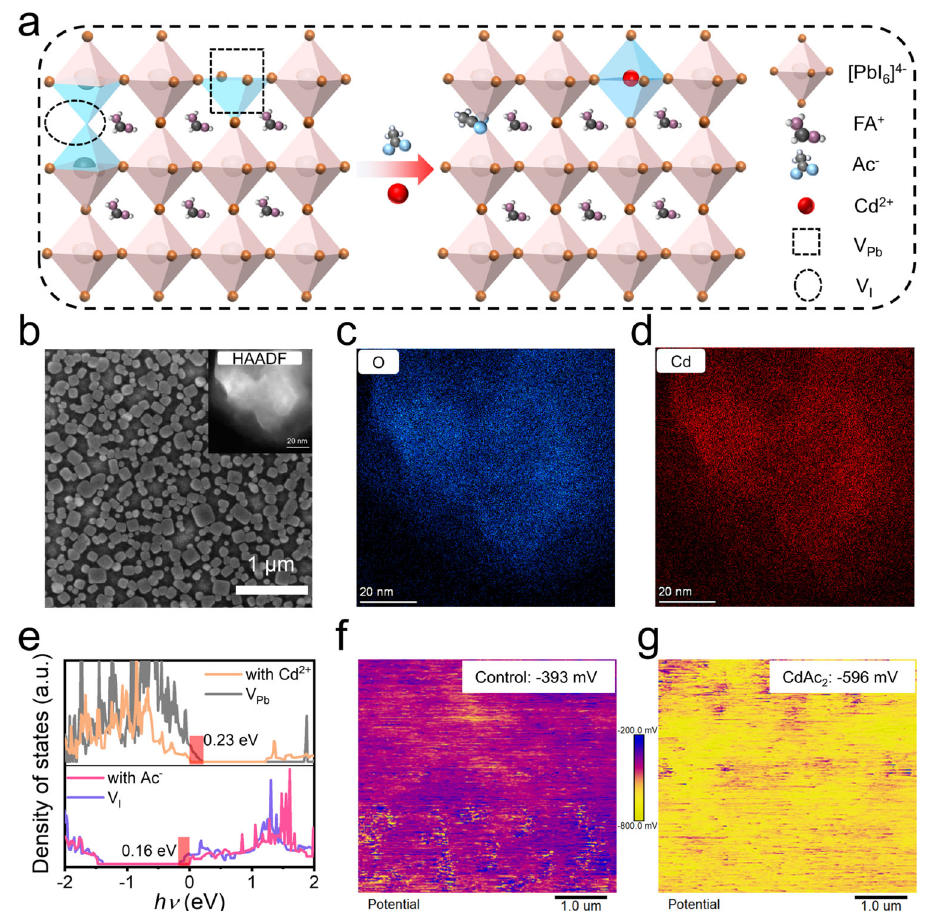
Fig. 1 | Effects of CdAc 2 on perovskite grains and fi lms. a Schematic diagram of defect passivation on the FAPbI 3 perovskite grain surface by CdAc 2 . b Scanning electronmicroscope(SEM)imageofaFAPbI 3 perovskite fi lmwith2.5%CdAc 2 ,the scale bar for the image is 1 μ m. Inset: a HAADF-STEM image of a perovskite grain extracted from the CdAc 2 -added FAPbI 3 without 5AVA. Energy-dispersive